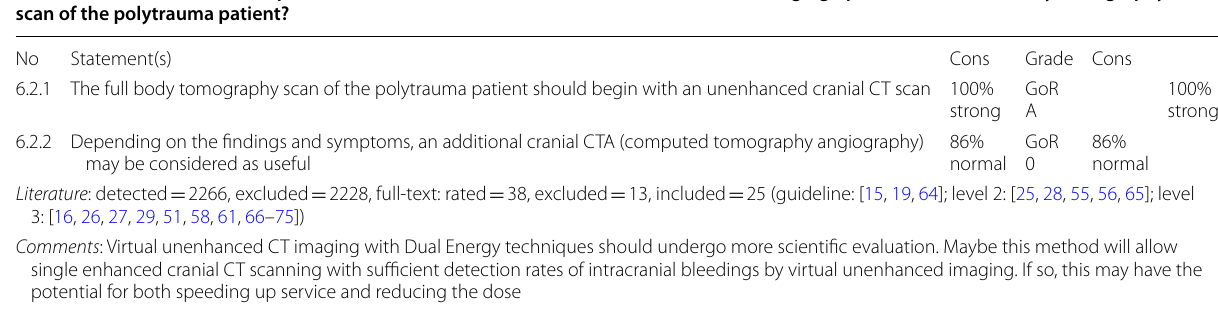
Table 11 Section 6: Whole Body CT – Protocol, key issue 2: Cranial CT Is an unenhanced cranial scan preferred to a cranial scan with contrast medium as first imaging option in the whole-body tomography scan of the polytrauma patient?